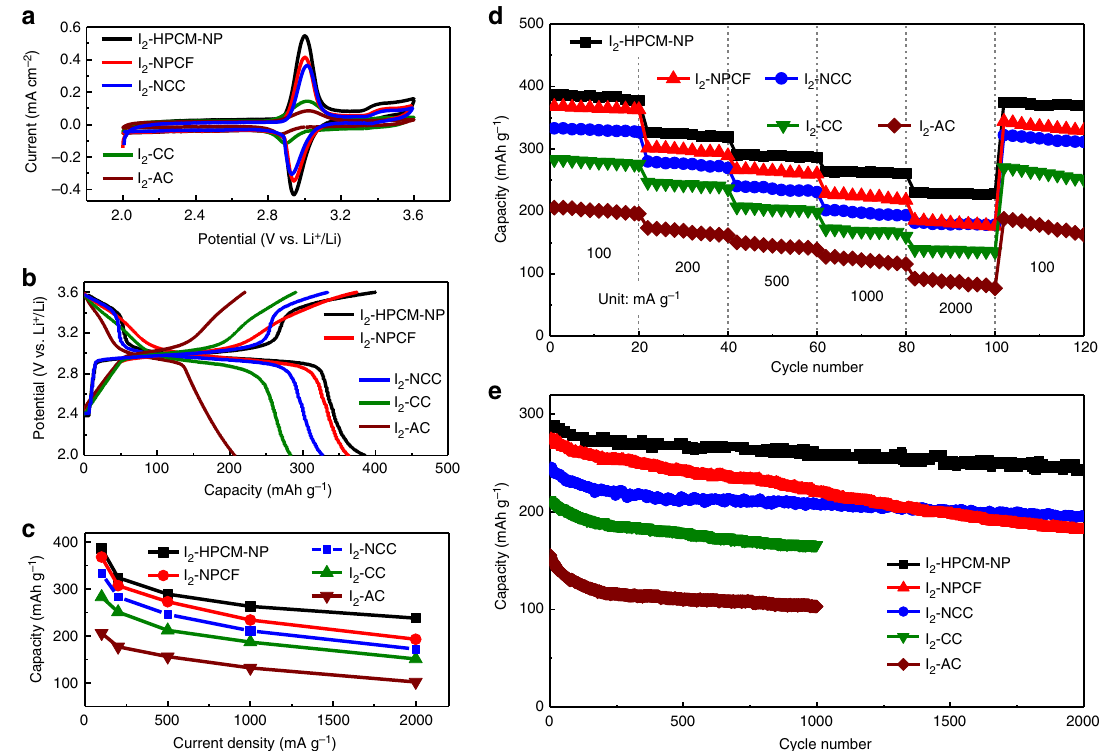
Fig. 3 Electrochemical performance of different iodine cathodes for Li – I 2 batteries. a Cyclic voltammograms (0.1 mV s − 1 ), b charge/discharge voltage pro fi les (100 mA g − 1 ), and c speci fi c discharge capacities of different iodine-carbon cathodes between 2.0 and 3.6 V with the same iodine loading